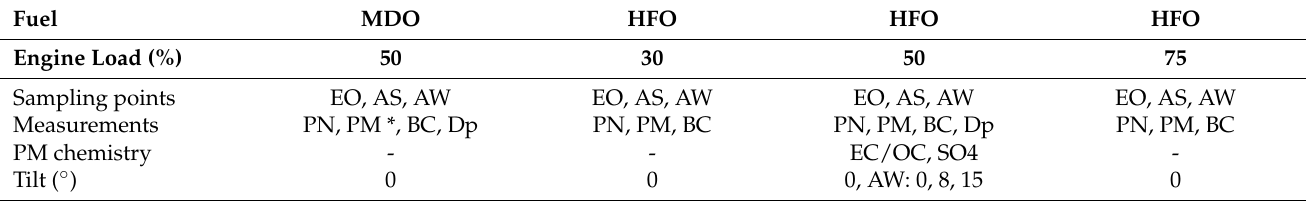
Table 2. Measurement matrix. Dp refers to particle diameter (size distribution) and SO4 to